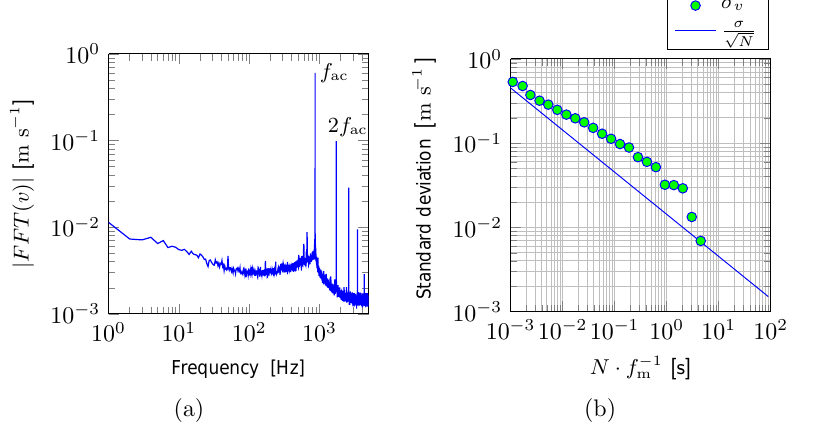
Figure 6. (a) Spectrum of the flow velocity and (b) standard deviation σ v of the mean flow velocity, calculated directly from the velocity series by averaging over N velocity samples. Estimated standard deviation σ/ sured velocity samples without averaging. Both standard deviations depend on the averaging time N/f m with the measurement rate f m for the measurement point at ( x,y,z ) = (0 , 3 . 6 , 0mm).